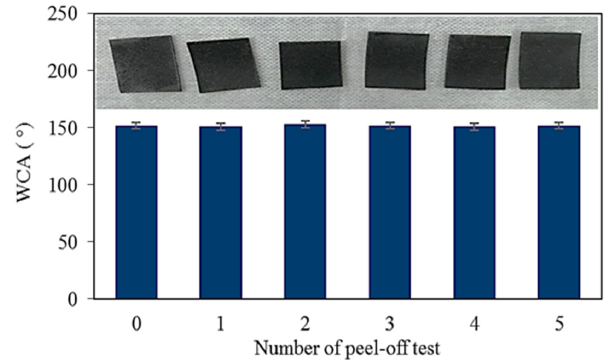
Figure 5. Changes in water contact angle of after peel-off test and appearance of surface of initial and peeled off tape after each peel-off